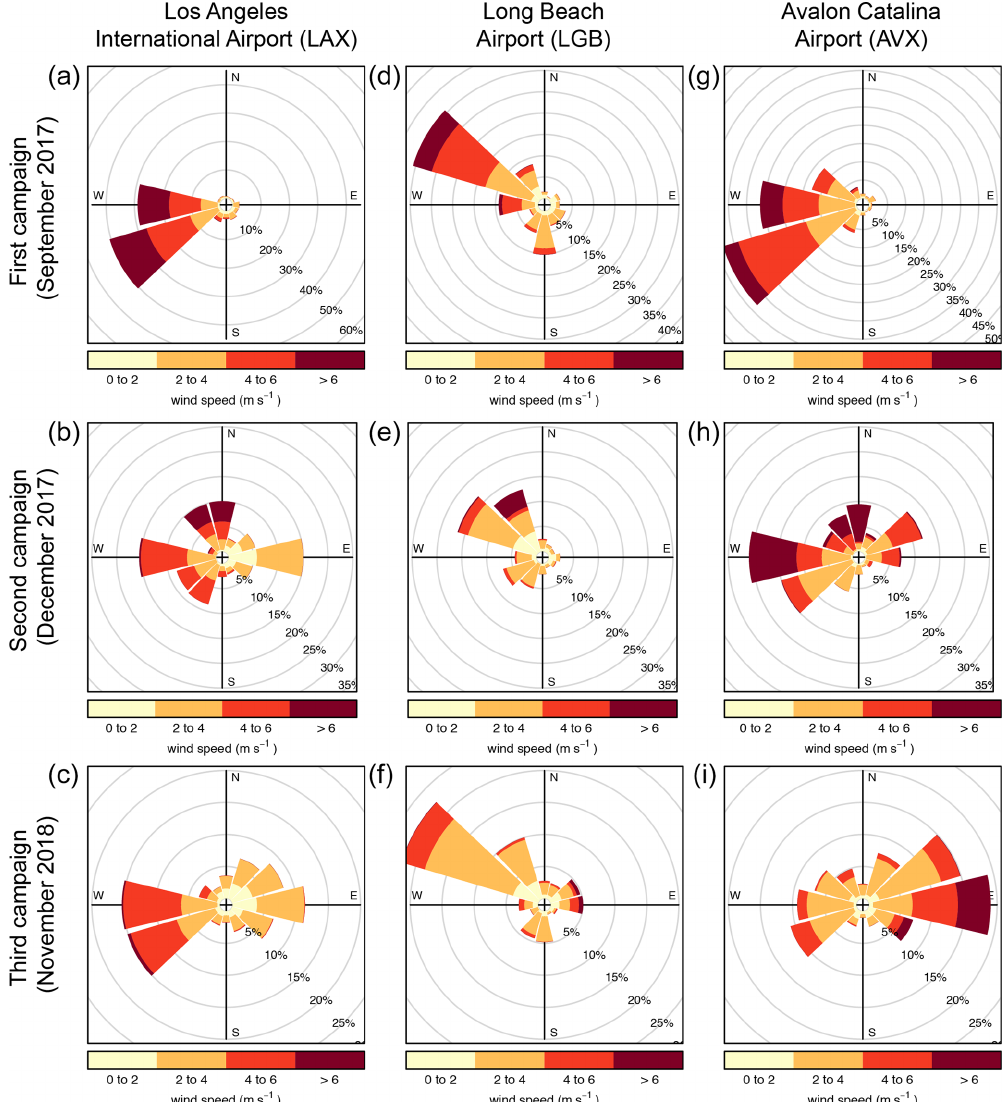
Figure 2. Wind roses for the September 2017 (a, d, g) , December 2017 (b, e, h) , and November 2018 (c, f, i) sampling periods. Wind roses are based on 5min Automated Surface Observing System (ASOS) airport data from LAX (a–c) , LGB (d–f) , and AVX (g–i) , provided by